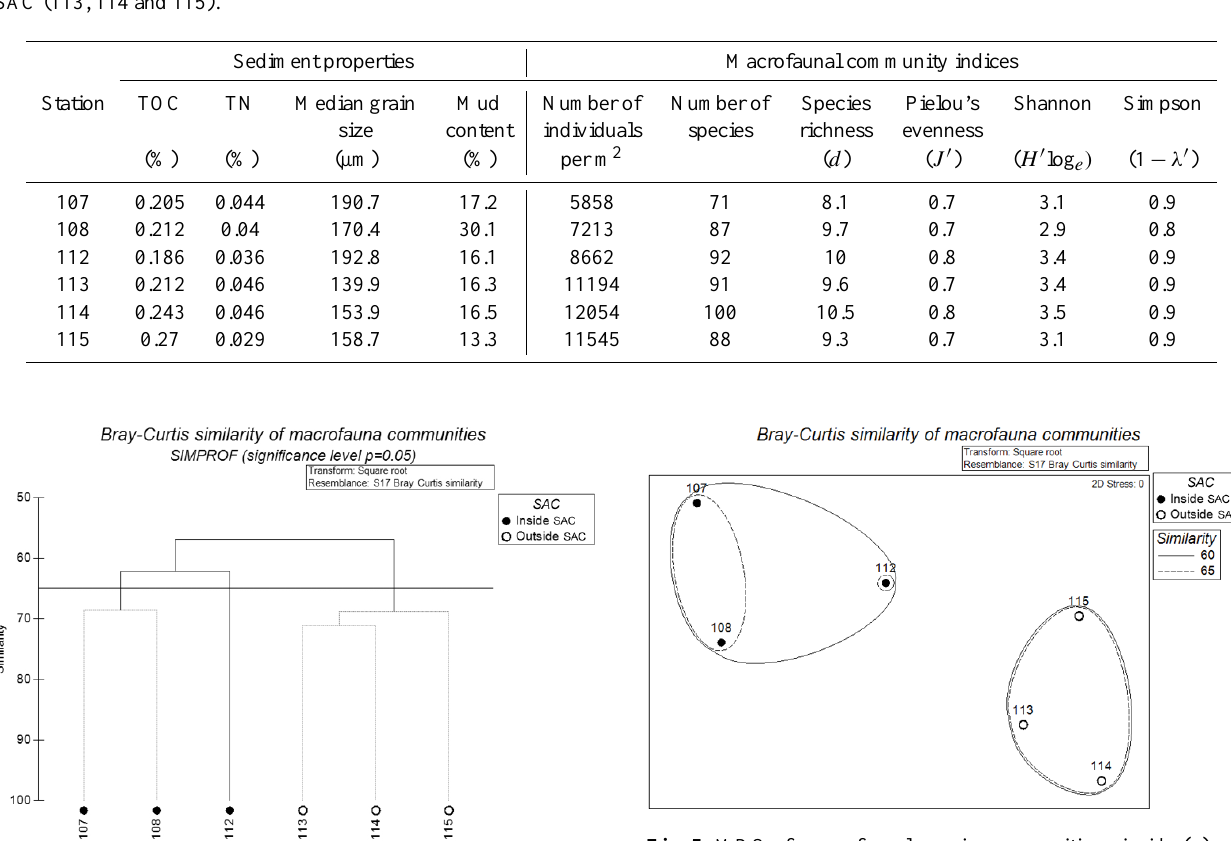
Fig. 5. MDS of macrofaunal species compositions inside ( • ) and outside ( ◦ ) the